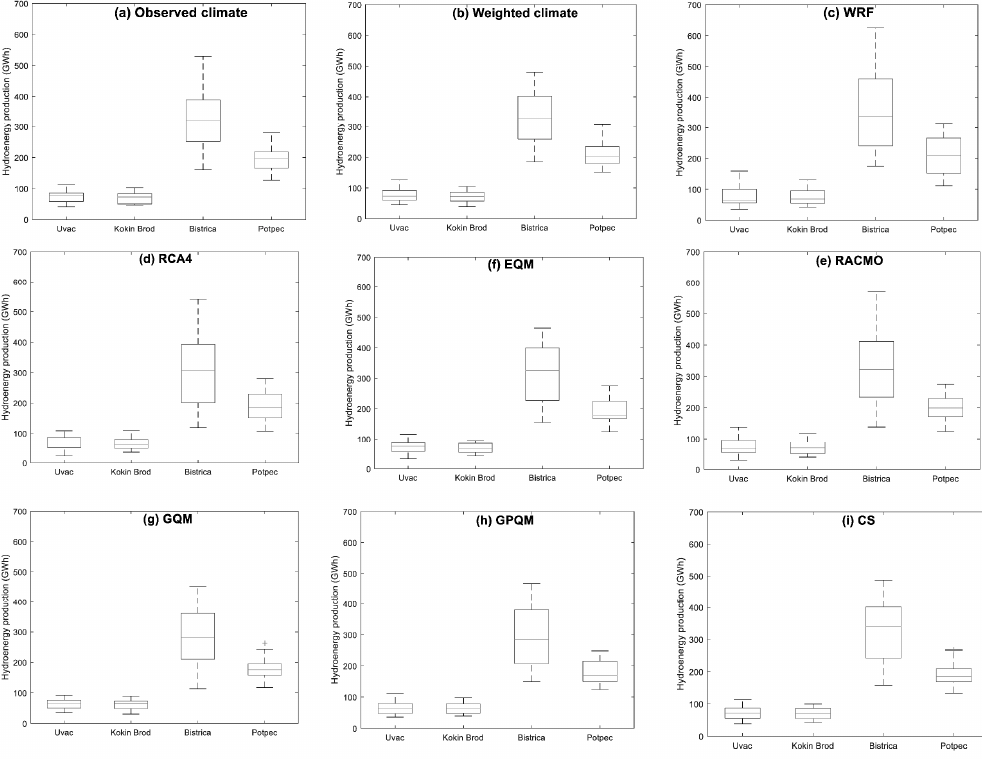
Figure 6. Annual hydropower generation of the Lim water system estimated with the following climate datasets: ( a ) Observed climate, ( b ) weighted climate simulations, ( c – e ) regional climate model simulations—WRF, RCA4, RACMO, ( f – i ) bias correction methods—EQM, GQM, GPQM, CS.